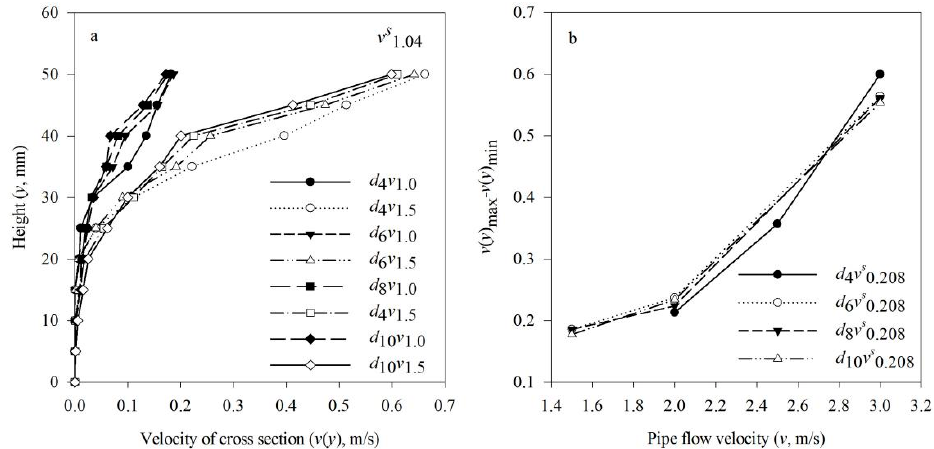
Figure 10. Relationship between vertical velocity distribution of particles and pipeline velocity. ( a ), gathering transportation; ( b ), suspension transportation; v ( y ) max , maximum vertical distribution velocity of particles; v ( y ) min , minimum vertical distribution velocity of particles.